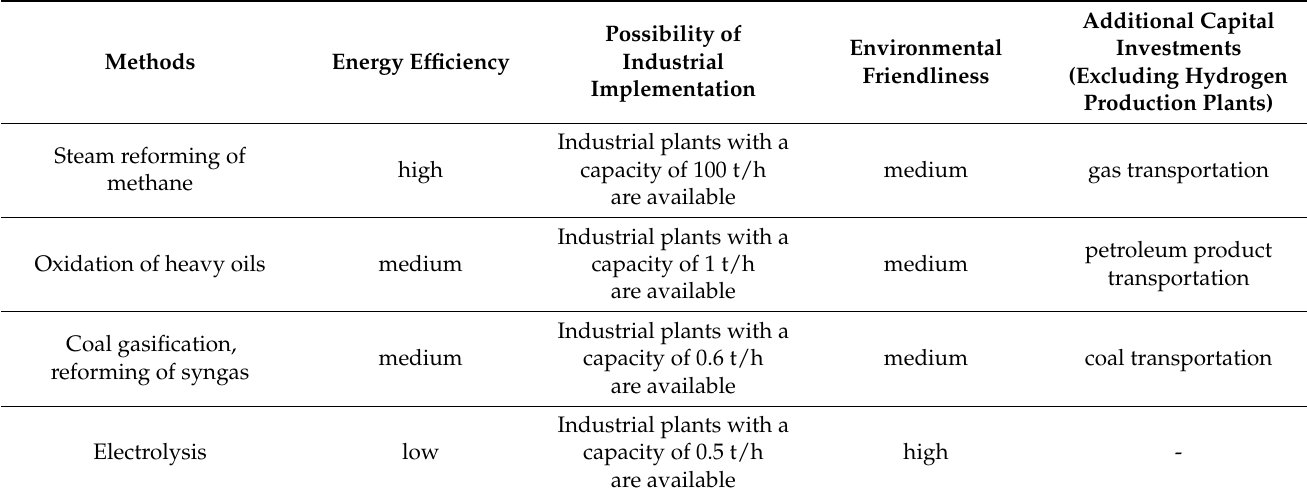
Table 4. Other technical and economic characteristics of hydrogen production